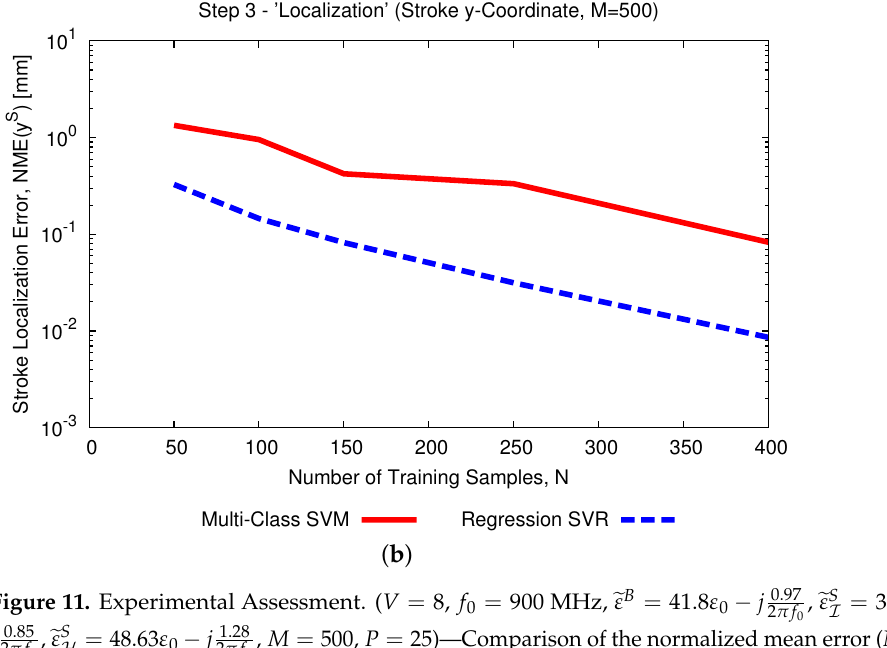
, (cid:101) ε S I = 32.04 ε 0 − 2 π f 0